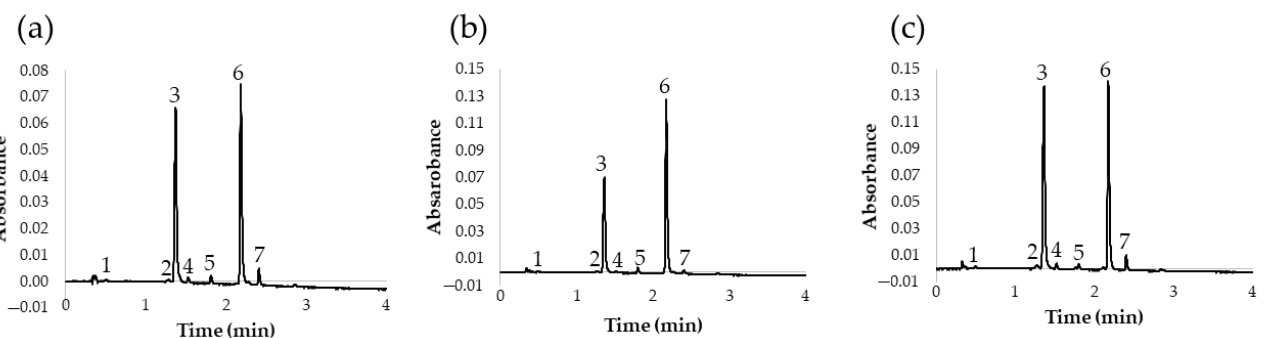
Figure 5. Chromatogram at 360 nm of different onion varieties: ( a ) white onion; ( b ) yellow onion; ( c ) red onion. (1) Quercetin 3,7,4 ′ - O -triglucoside; (2) quercetin 7,4 ′ - O -diglucoside; (3) quercetin 3,4 ′ - O -diglucoside; (4) isorhamnetin 3,4 ′ - O -diglu- coside; (5) quercetin 3- O -glucoside; (6) quercetin 4 ′ - O -glucoside; (7) isorhamnetin 4 ′ - O -glucoside.